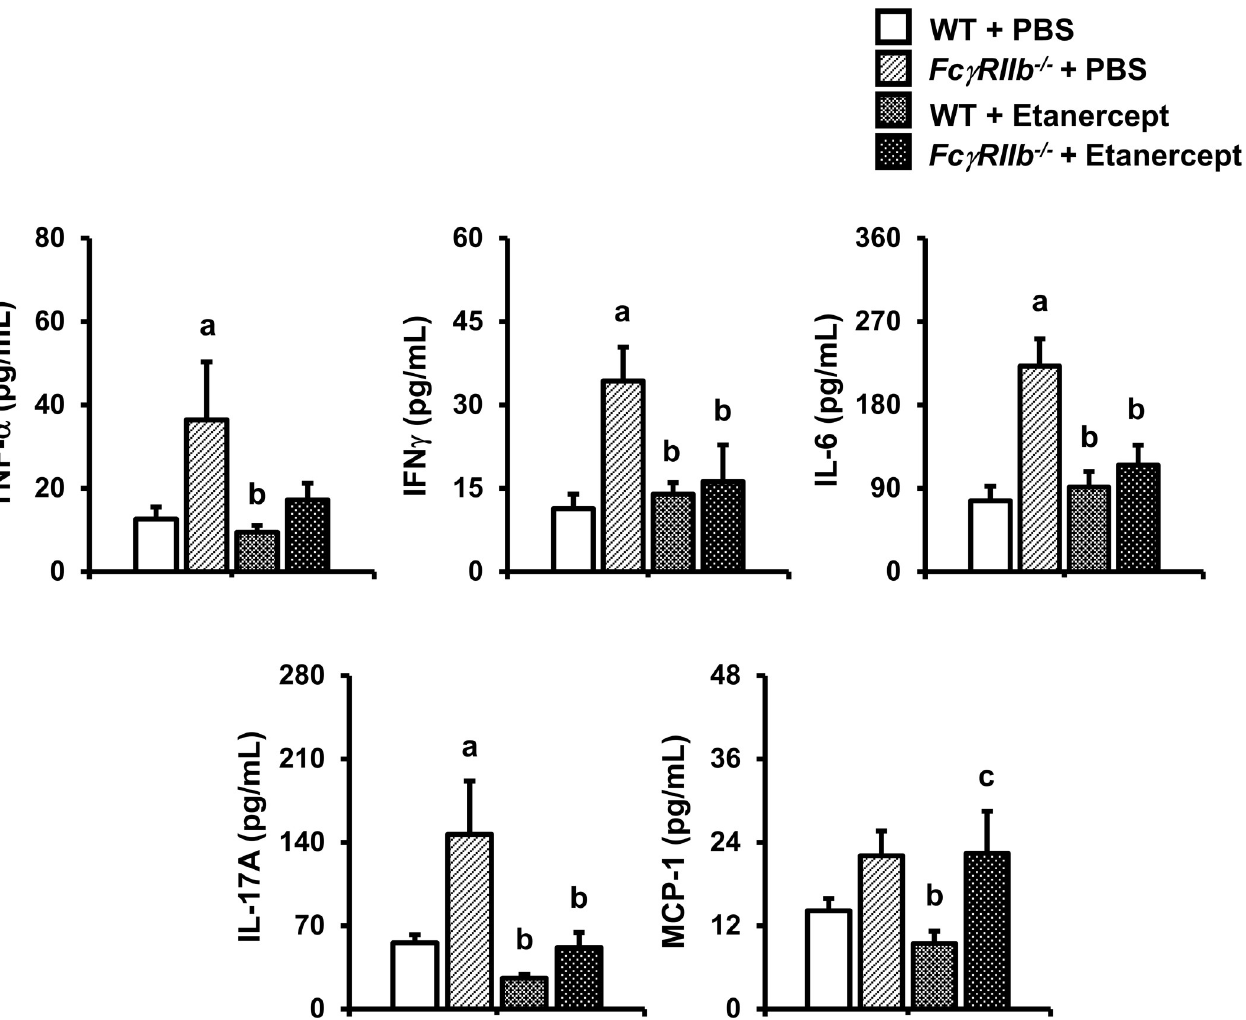
Fig 4. Inflammatory cytokines are reduced by TNF- α antagonist. Serum levels of TNF- α , IFN γ , IL-6, IL-17A, and MCP-1 in Fc γ RIIb -/- mice and WT controls after treatment with either PBS or etanercept. Data are mean ± SEM (n = 5–7). a p < 0.05 versus WT controls-treated with PBS, b p < 0.05 versus Fc γ RIIb -/- mice-treated with PBS, and c p < 0.05 versus WT controls treated with